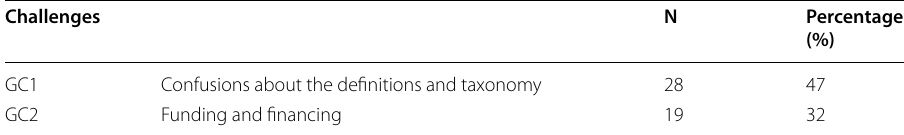
Table 8 Summary view of the critical challenges of micro-credentials implementation from governments’